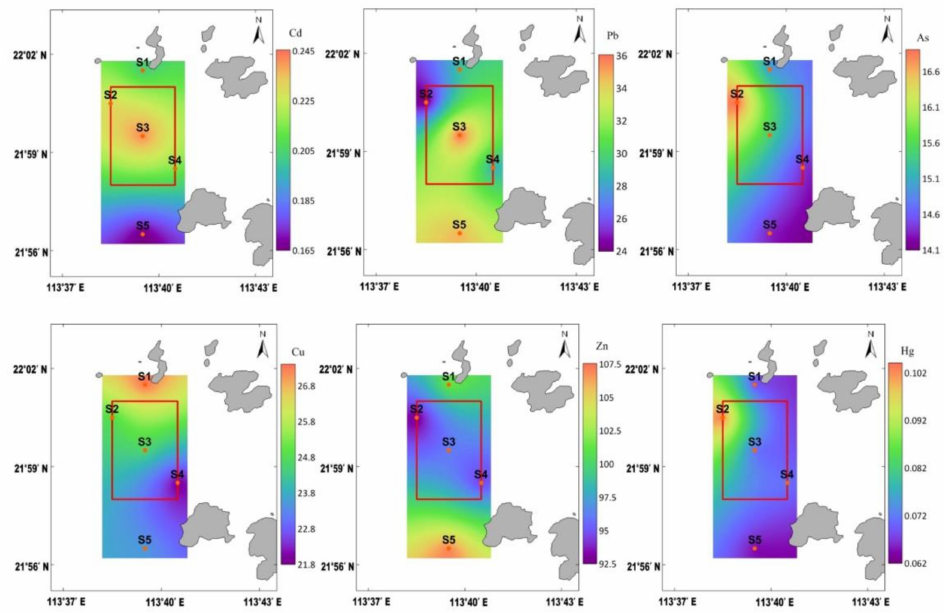
Figure 3. Spatial distribution of HMs in